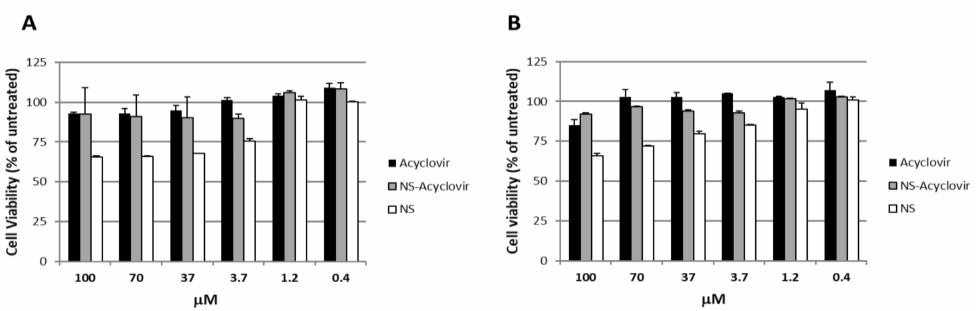
Figure 5. Effect of acyclovir, acyclovir-loaded NS, and only NS on the viability of non-infected Vero cells as a function of the drug concentration at 24 h ( A ) and 48 h ( B ). X axis: NS concentration, Y axis: cell viability (% of untreated control). Each point represents the mean ± SD ( n =